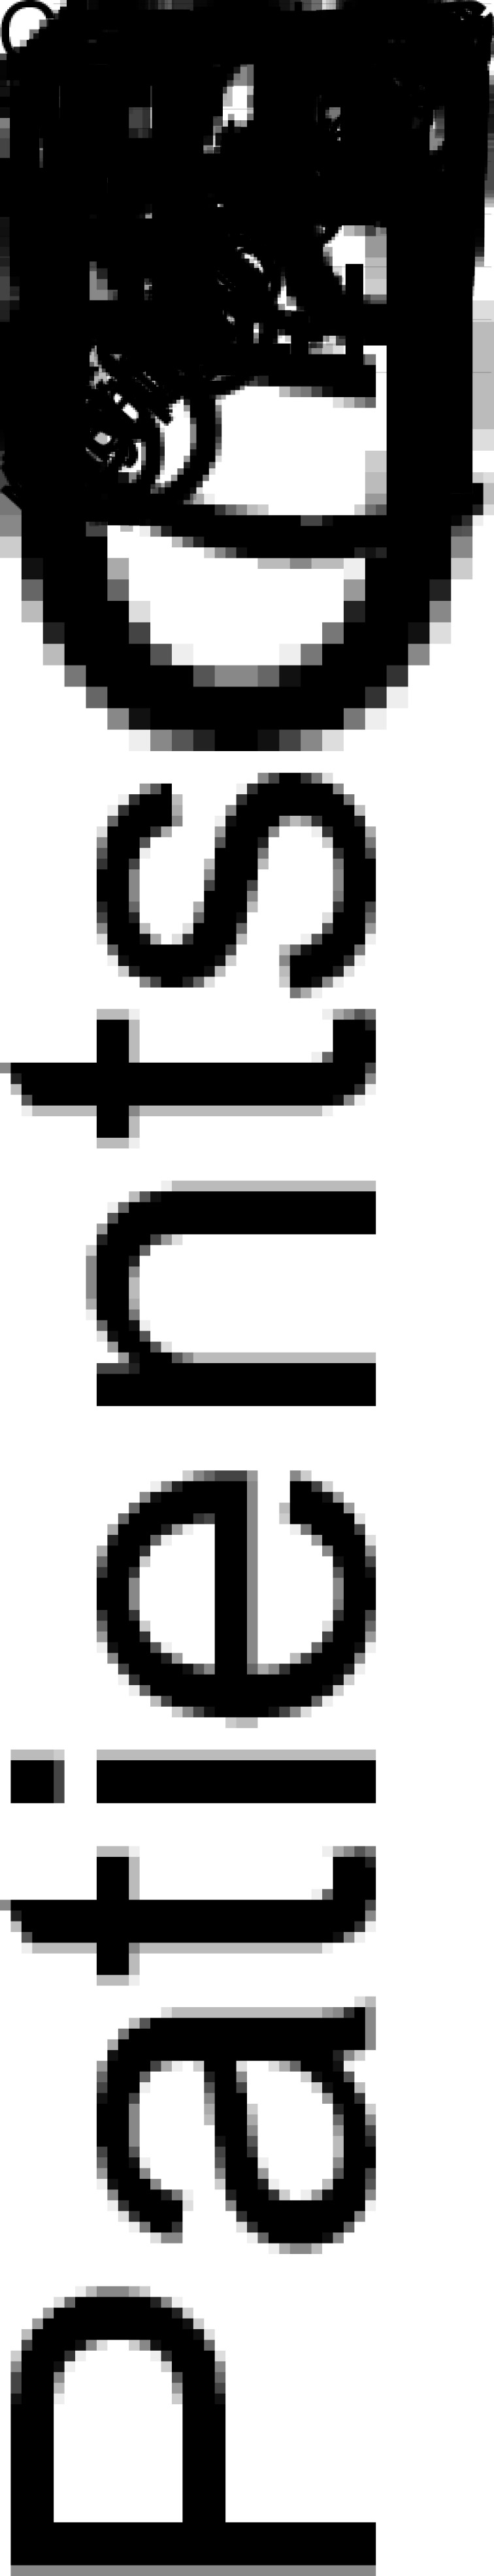
Distribution of patients according to medical co-morbidities. COPD = chronic obstructive pulmonary disease; CVD = cardiovascular disease